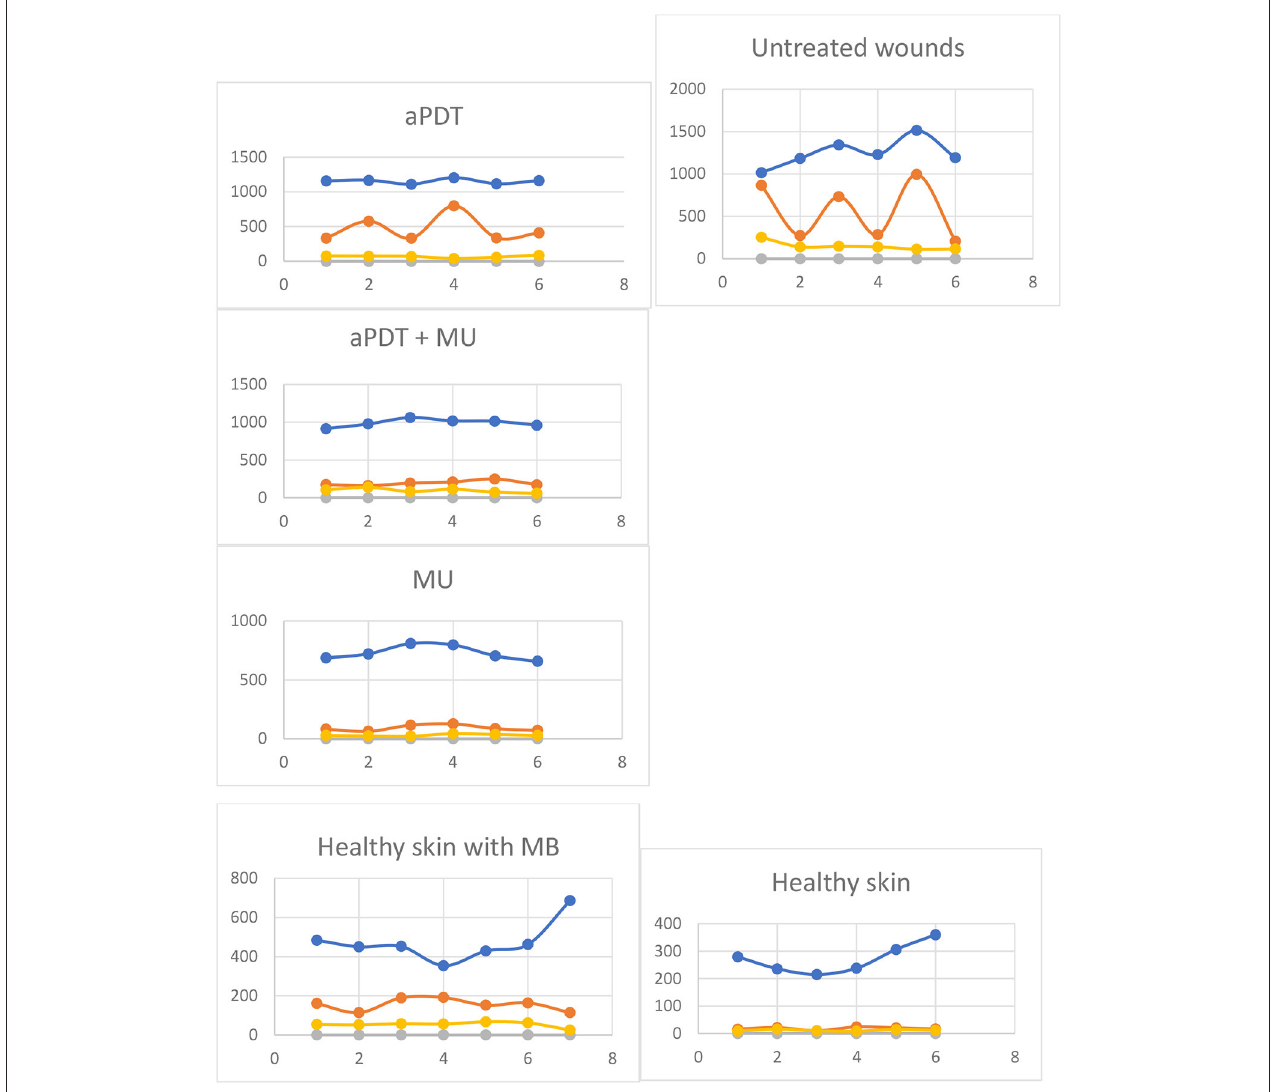
FIGURE 4 | Dispersion of thickness of epidermis, dermis, and hyperkeratosis ( Table 5 ) in wounds of SKH-1 mice on therapy or healthy skin. Blue: Dermis. Orange: Epidermis. Yellows: Hyperkeratosis. Vertical Axis: Thickness µ m (mean ± SD). Horizontal axis: number of data.